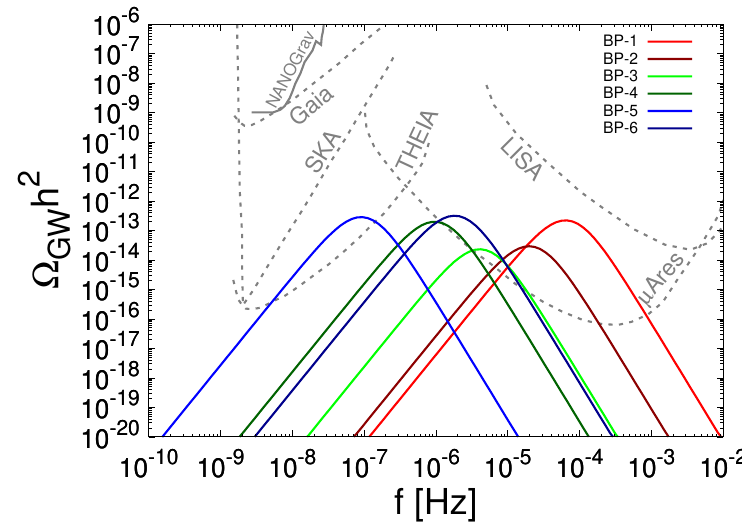
Figure 3 . Gravitational wave power spectra for the benchmark points in table 1.